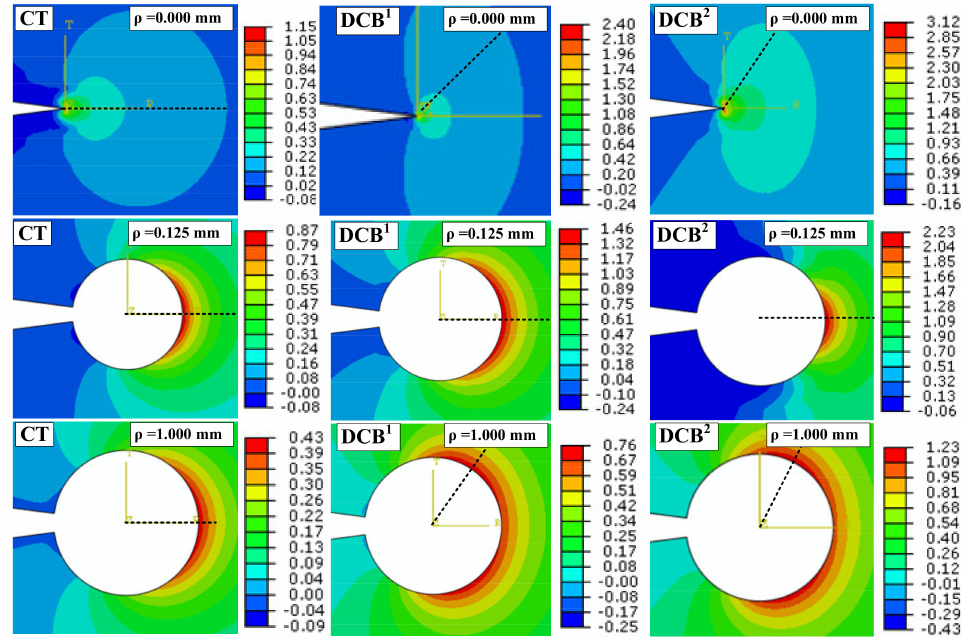
Figure 4. TS contours around VO-notches for CT and DCB models with various radii ( γ = 15 ◦